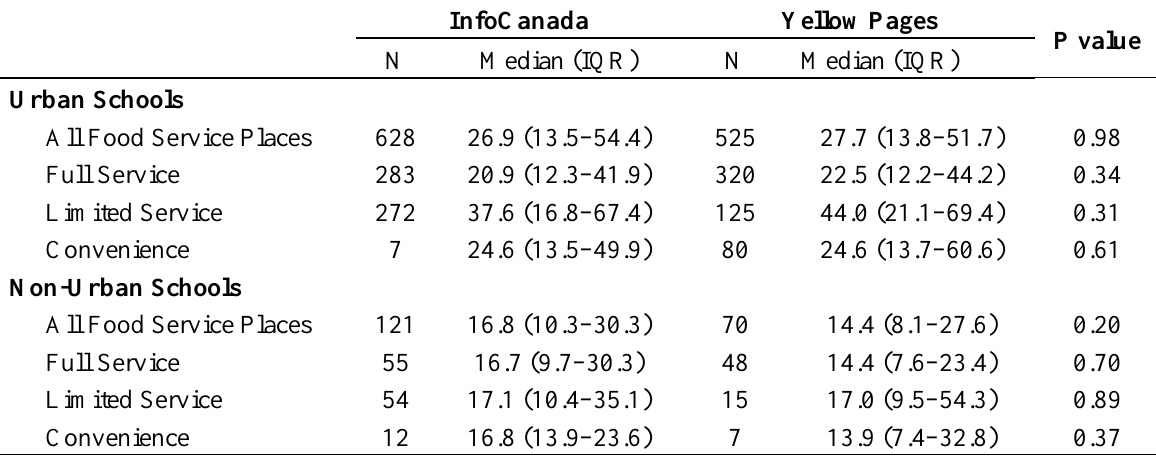
Table 2. Positional error (meters) of food service place locations provided the GIS